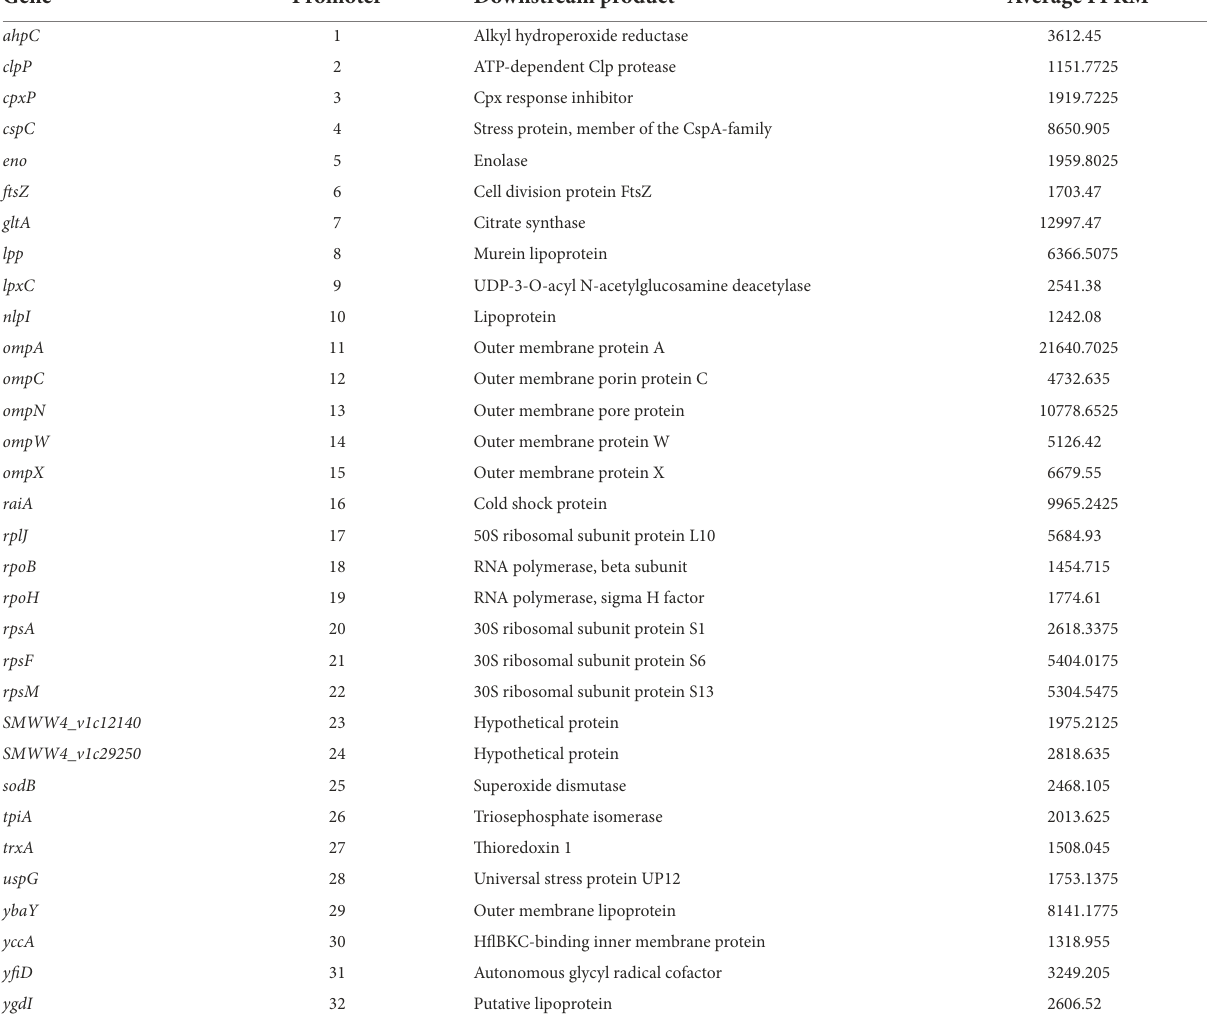
TABLE 2 Identified genes with high level expression from RNA-seq